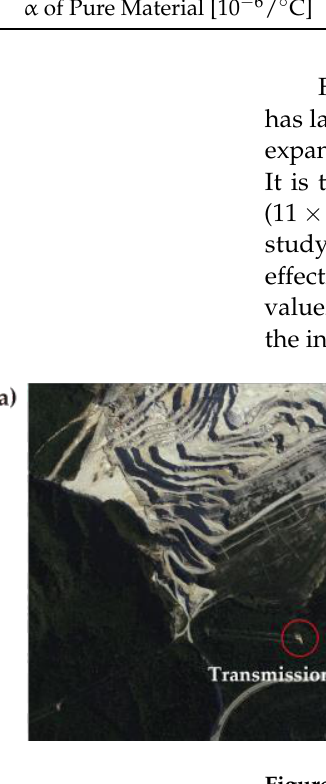
Figure 13. Seasonal LOS displacement of a transmission tower located near the mining area, as shown in the left aerial photograph taken in 2021. ( a ) Transmission tower; ( b ) time-series plots of displacement in transmission tower. Table 4. Calculation of the thermal expansion coefficients of exposed limestone rocks and the trans- mission iron tower.